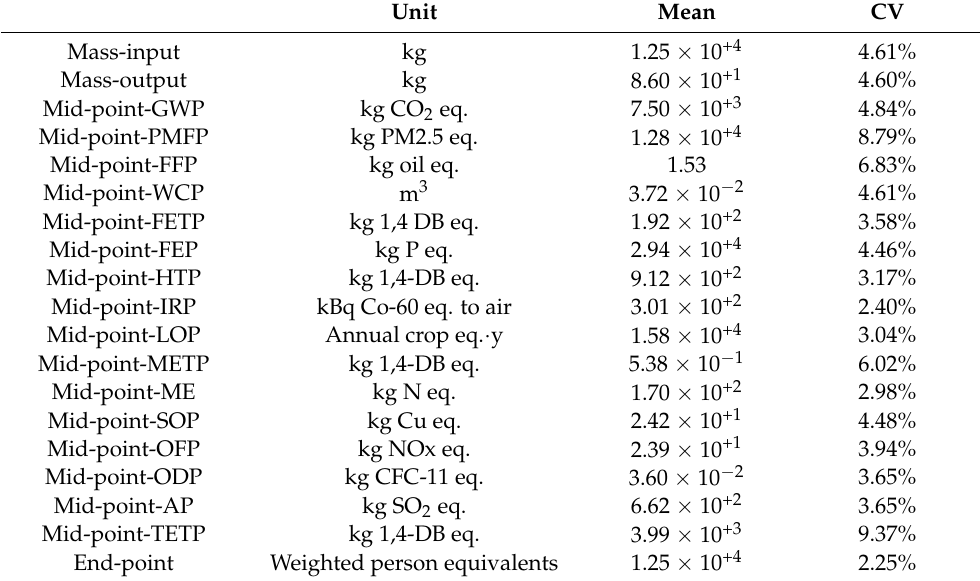
Table 6. Monte Carlo analysis of the results of the silver dividing processes LCA. Unit